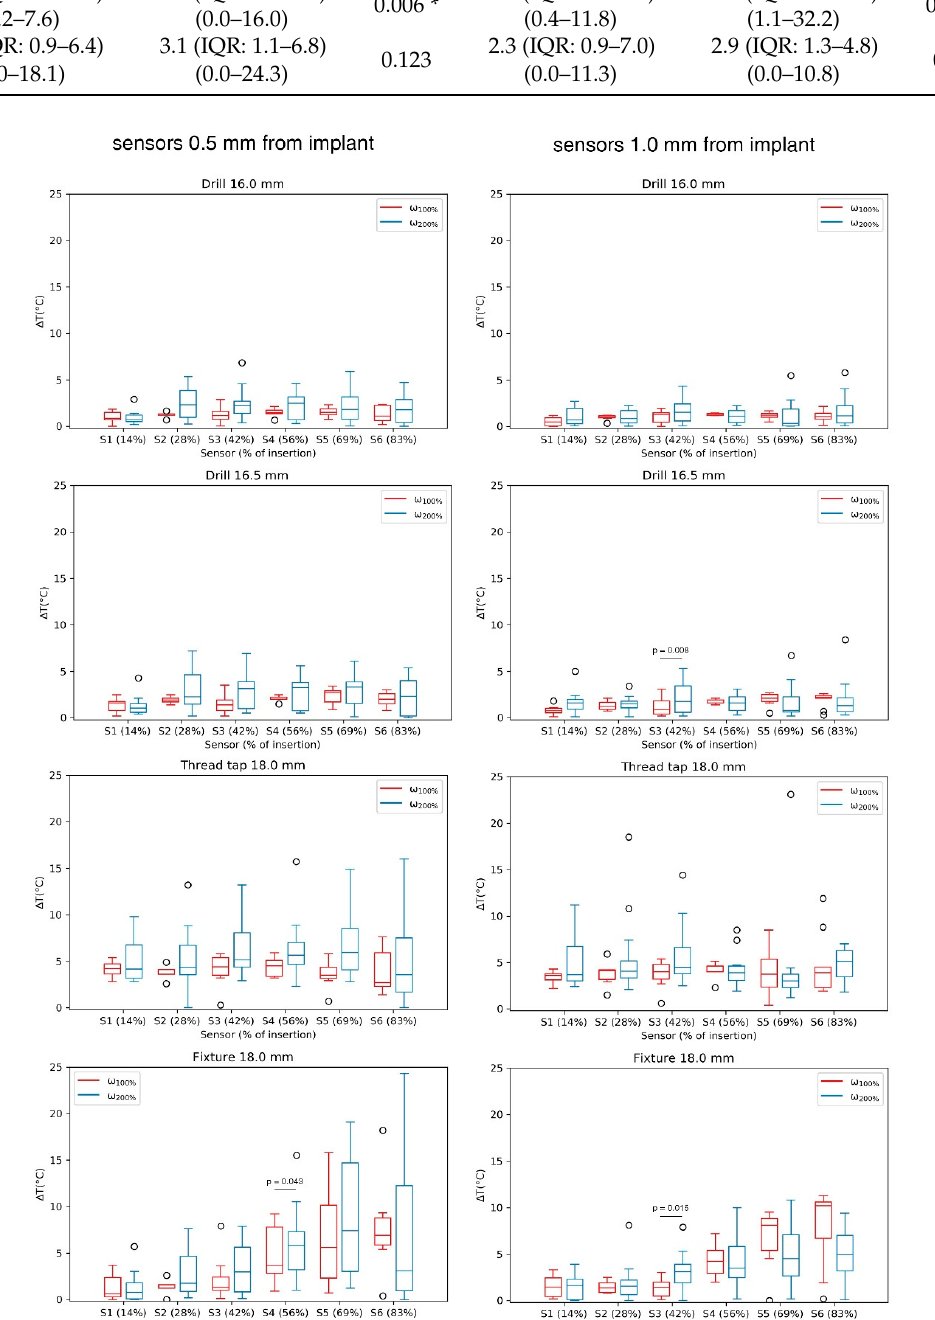
Figure 5. Maximum temperature increase measured for the final four surgical steps measured by 12 thermocouples (6 at 0.5 mm and 6 at 1.0 mm from the fixture's surface). Each box denotes the 25th through 75th percentiles, the bar within the box denotes the median value, and the whiskers extend 1.5 times the interquartile range above and below the 75th and 25th percentiles. Observations beyond the whiskers are plotted individually.